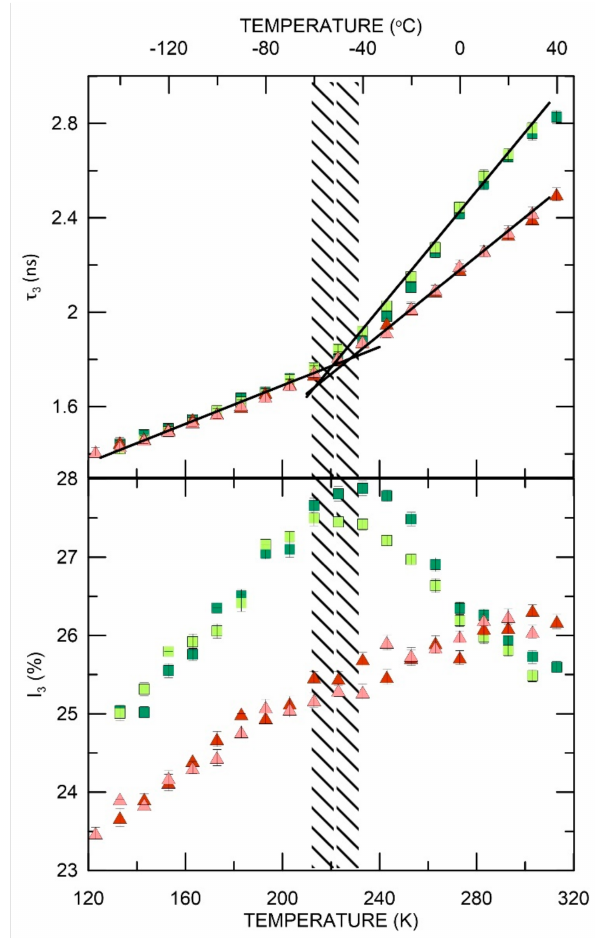
Figure 5. AESO/VDM, AESO/VDM/DMPA: the o-Ps lifetime and intensity as a function of in- creasing (AESO/VDM—dark green squares, AESO/VDM/DMPA—red triangles) and decreasing (AESO/VDM—light green squares, AESO/VDM/DMPA—pink triangles)